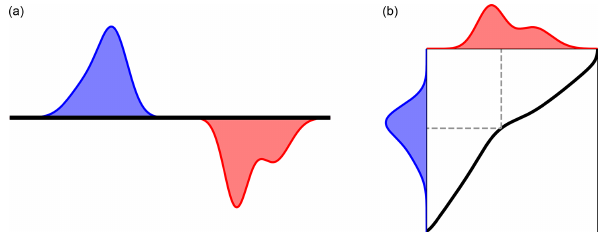
Figure 4. Panel (a) shows Monge’s initial formulation of OT, with a source mass distribution (blue) and a target to be filled (red). Panel (b) shows the solution to the OT problem, with a transport map (black) transporting the source to the target. Dashed line shows the transport for a particular